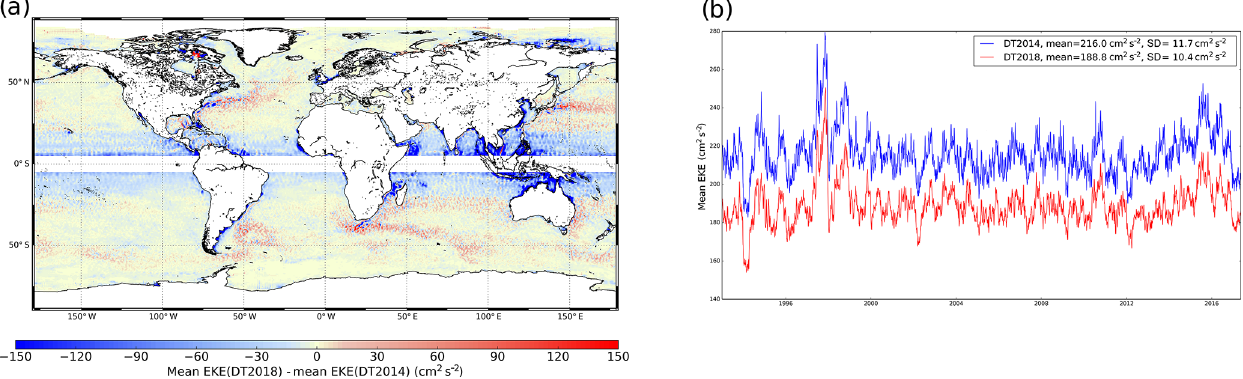
Figure 4. Map of the difference between mean EKE for DT2018 and DT2014 gridded products (a) and the evolution of the mean EKE over the global ocean, computed from DT2014 (blue line) and DT2018 (red line) SLA gridded products (b) over the 1993–2017 period. The ± 5 ◦ N equatorial belt has been